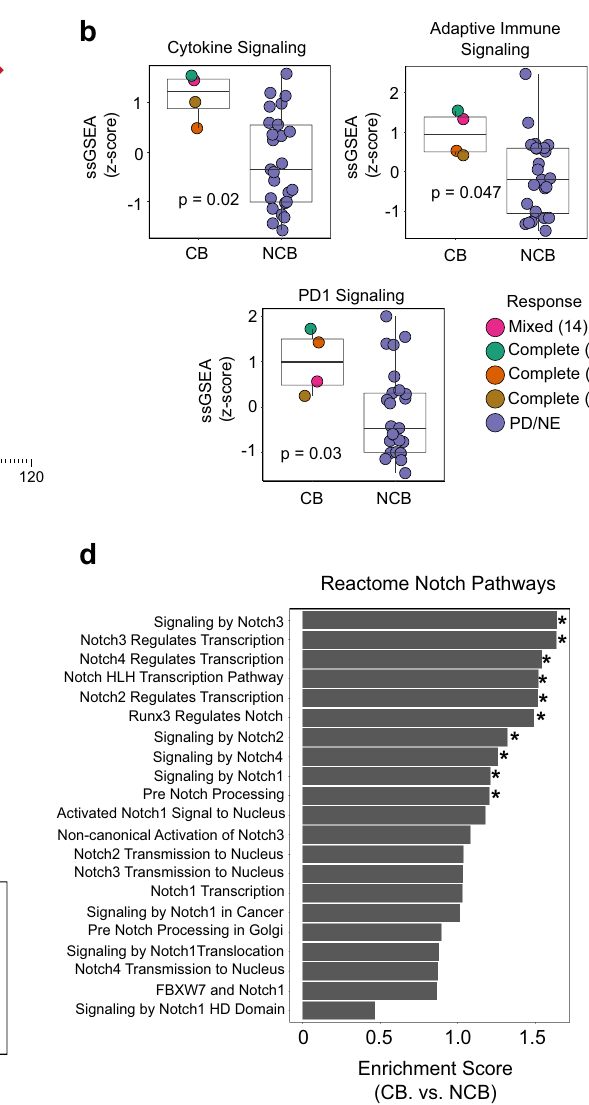
Fig. 3 Validation of the association between Notch signaling and immune gene sets and clinical bene fi t to immune checkpoint blockade in relapsed small cell lung cancer. a Swimmer plot indicating response and length of time on therapy for individual patients in the Rochester validation cohort. Patients with clinical bene fi t (CB) are those with complete or mixed response and patients with no clinical bene fi t (NCB) are those with progressive or not evaluable disease. b ssGSEA Reactome immune gene set scores and c ssGSEA Hallmark Notch signaling gene set score in tumors of patients with and without clinical bene fi t to ICB. Each circle represents a tumor from a given patient. d Enrichment of Reactome gene sets related to Notch signaling in patients with clinical bene fi t to ICB. Asterisks denote signi fi cantly enriched gene sets (unadjusted p < 0.05). e ssGSEA scores of Reactome gene sets related to receptor tyrosine kinase and MET activation in tumors of patients with and without clinical bene fi t following ICB. Statistical signi fi cance was tested with a two-tailed Mann – Whitney U test. Boxplots represent the median, 25th and 75th percentiles and the vertical bars span the 5th to the 95th percentiles. Timing of responses are not shown for individual patients in swimmer plot. PD progressive disease, NE not evaluable disease. Source data are provided as a Source Data fi